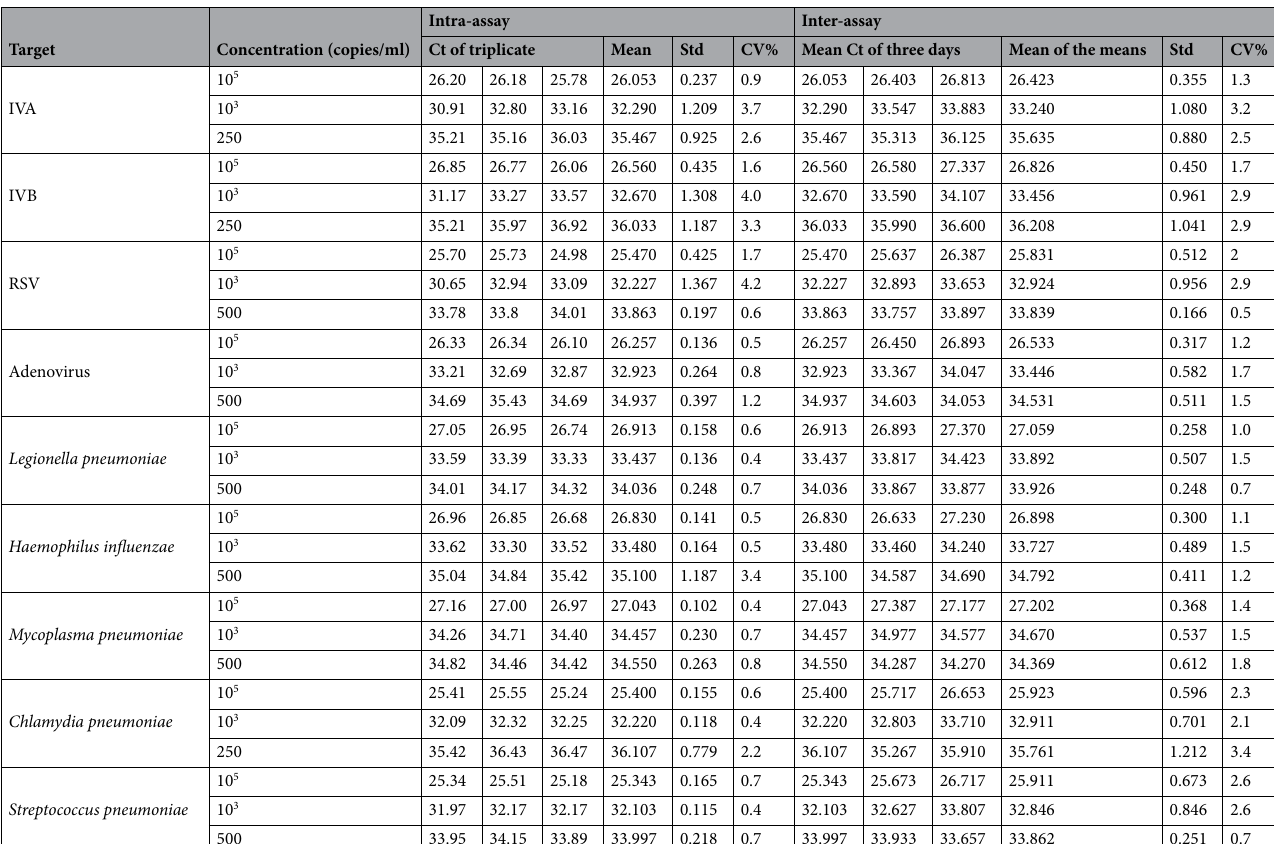
Table 2. Intra-assay and inter-assay of the multiplex real-time